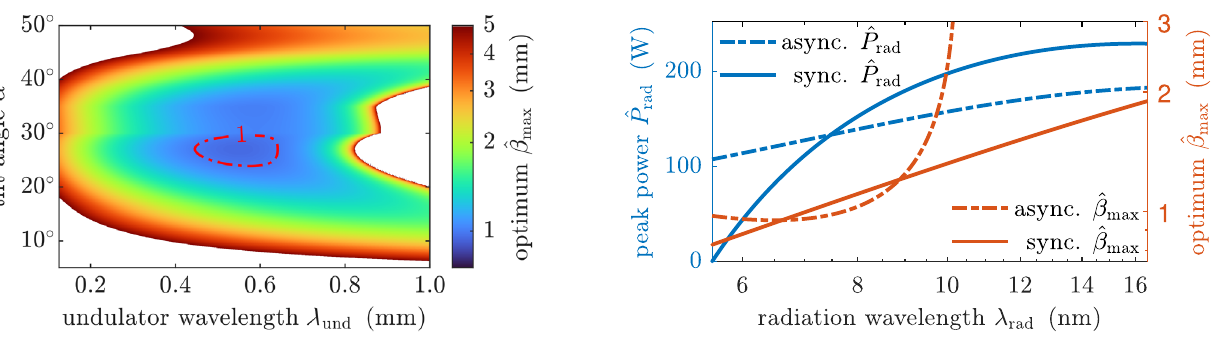
FIG. 9. Comparison of the optimum radiation wavelength, and the radiation peak power for both the synchronous and the asynchronous DLA undulator design at E 0 ¼ 10 GV = m drive-laser field